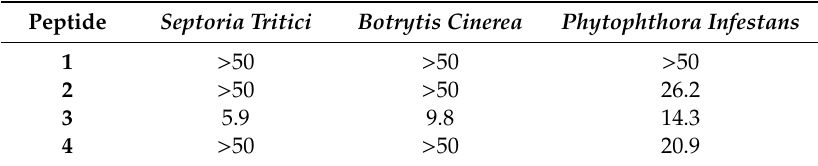
Table 1. Half maximal inhibitory concentration (in µ mol / L) of peptides 2 – 4 against model phytopathogens. (For more, detailed data see Supplementary Material) Peptide Septoria Tritici Botrytis Cinerea Phytophthora